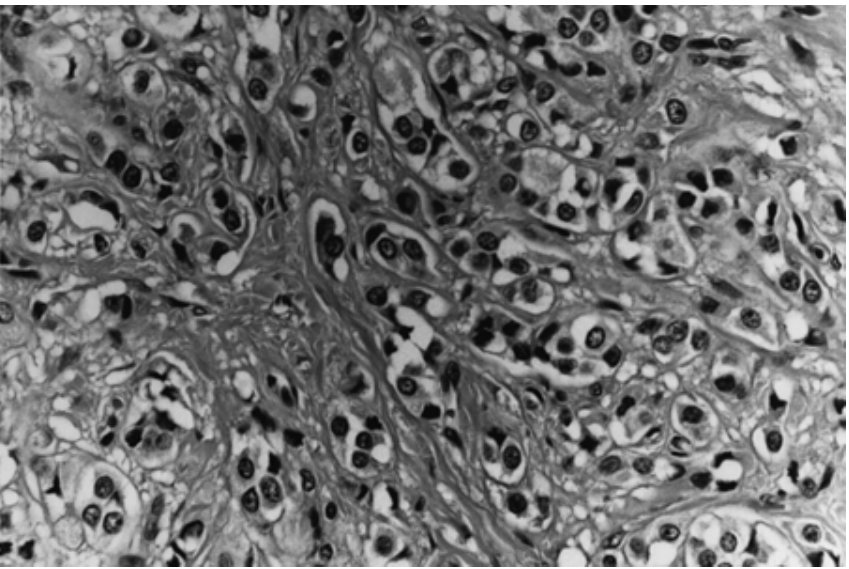
FIGURE 3B. Photomicrograph of a representative section of the tumor showing bland cellular structures in a dense fibrous background. (Hematoxylin and eosin, original magnification X